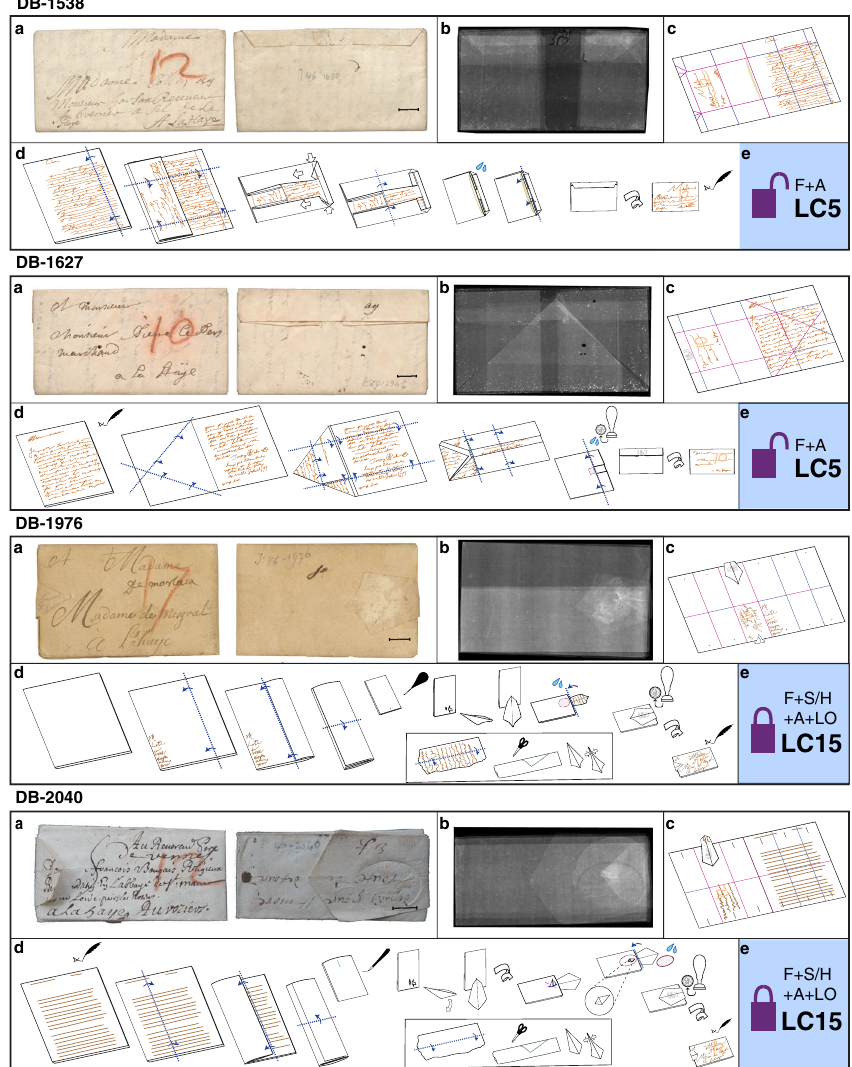
Fig. 1 Four letterlocking examples from the Brienne Collection. For each letterpacket (DB-1538, DB-1627, DB-1976, and DB-2040; “ DB ” numbers in this article refer to shelfmarks): a outside of letterpacket, front, and back; b transparent view through the volumetric XMT data showing varied distribution of layers across the letterpacket; c crease pattern that would be visible on the paper if fully opened, stylized from the output of virtual unfolding; d proposed step-by-step letterlocking process to make this packet from a fl at piece of paper, based on virtual unfolding results; e letterlocking category (LC#) assigned based on virtual unfolding fi ndings, letterlocking categories, and formats chart (see Fig. 7), apart from opened letter DB-2040, assigned based on surviving letterlocking evidence. For videos of the letterlocking process for each letter, see our Supplementary website brienne.org/unfolding. Scale bars: a 10